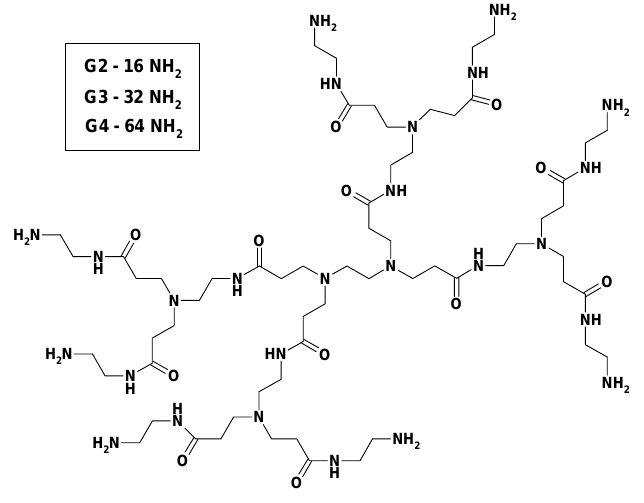
Figure 1. Chemical structure of PAMAM dendrimer